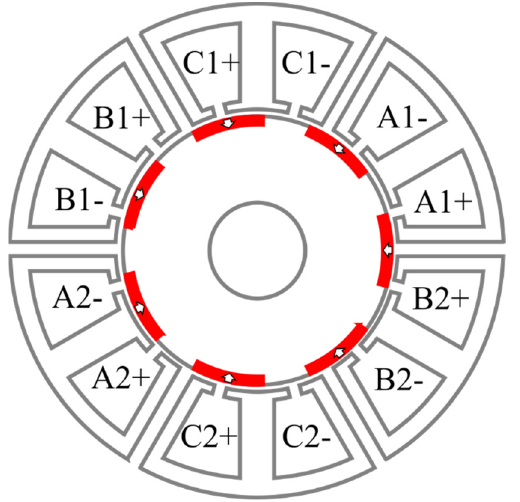
Figure 12. Axial air-cooled configuration with flux barriers used as vents [92,93].